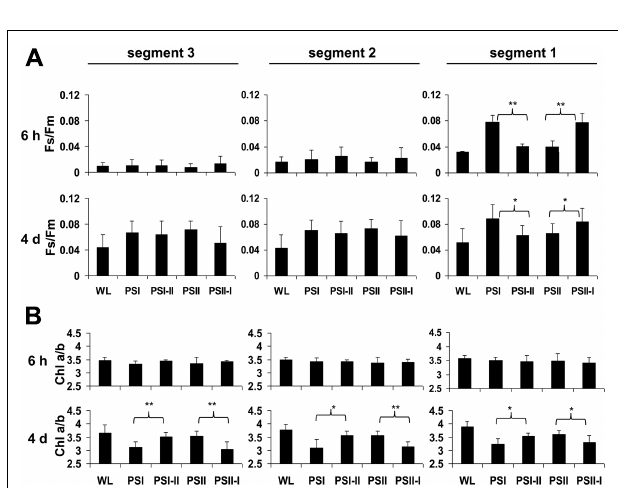
FIGURE 4 | Chl fluorescence and Chl a/b ratios in defined segments of maize seedlings acclimated in long-term to different artificial light qualities. Growth light conditions are given below the charts. Plants under PSI-light were shifted to PSII-light and vice versa and harvested 6 h of 4 days after the shift (indicated in the left margin) and compared to non-shifted controls. (A) F s / F m and (B) Chl a/b were determined from the same segments (indicated on top, compare Figure 3 ). Data represent at least three independent biological replicates, standard deviation is given. A Student’s t -test was performed to test significance of differences (* P < 0.05, ** P < 0.01).